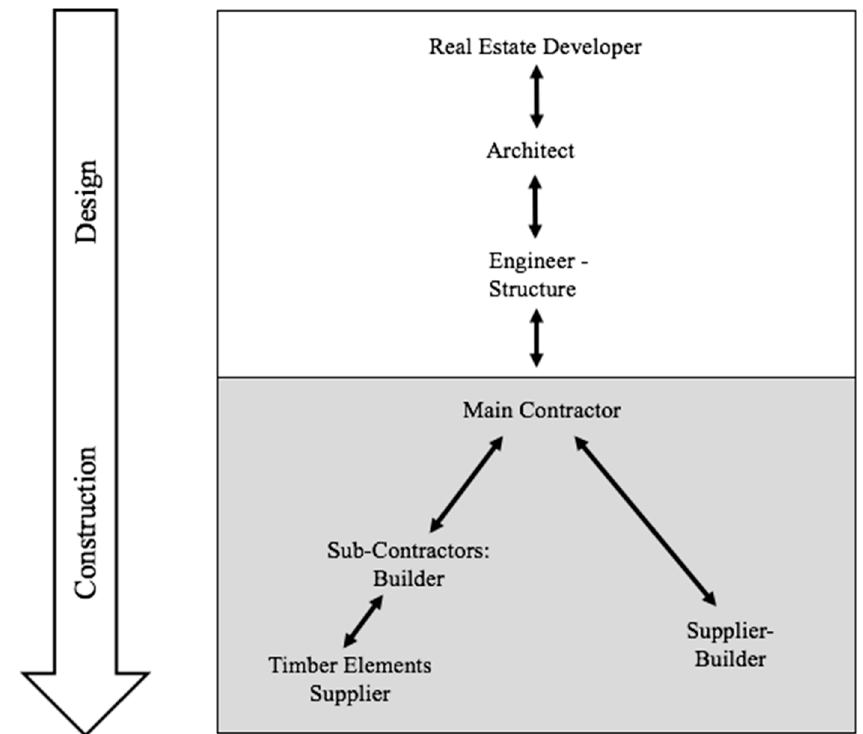
Figure 5. Typical structural timber building supply chain.